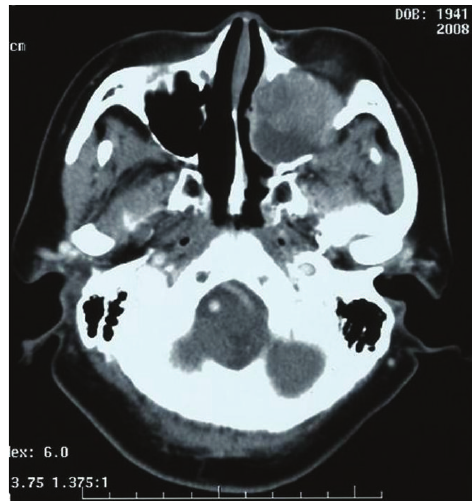
Figure 2: Tumor centered on the maxillary sinus with infiltration of the left orbit.